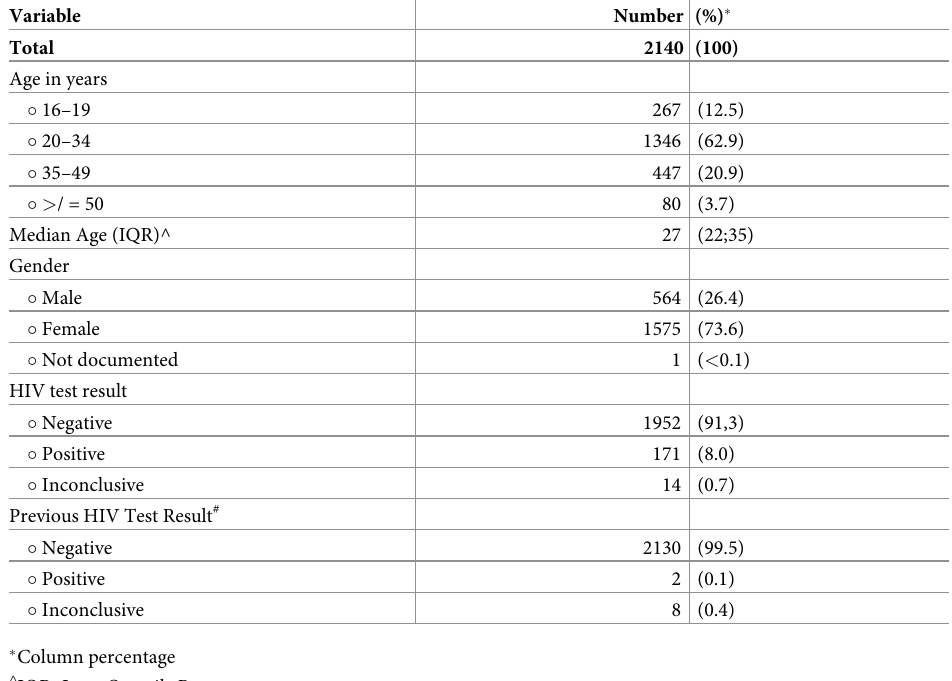
Table 2. Clinical and demographic profile of the patients screened for HIV testing in Zimbabwe, 2021. (N = 2140).